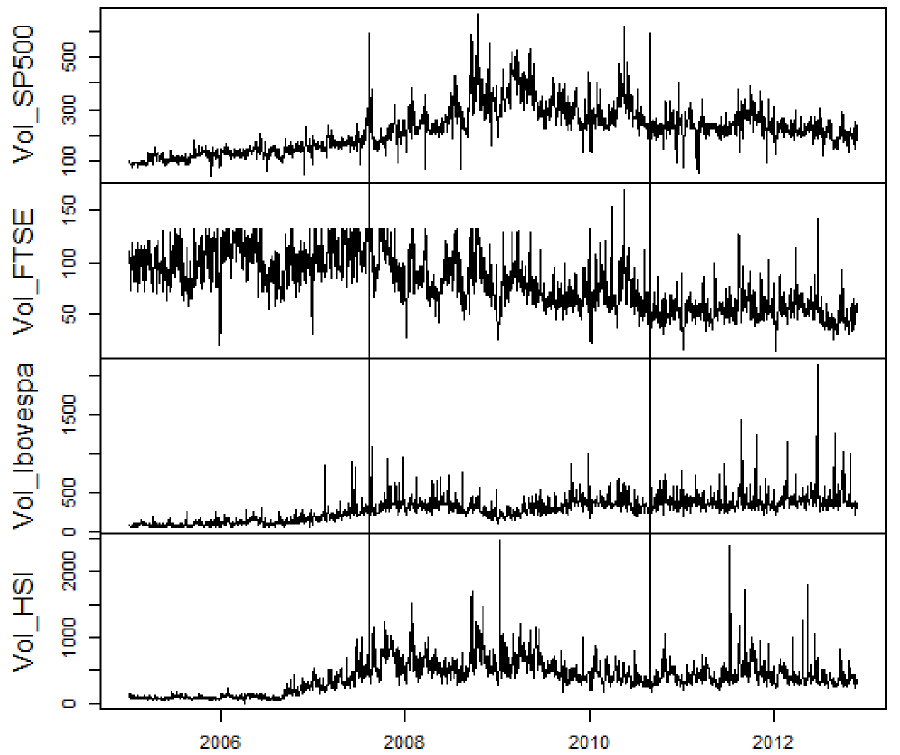
Figure 3. Daily volumes on basis 100 of S&P500, FTSE100, Ibovespa and HSI from January 2005 to November 2012. Vertical lines represent the subdivision into non-crisis, Sub-prime crisis and Eurozone crisis.